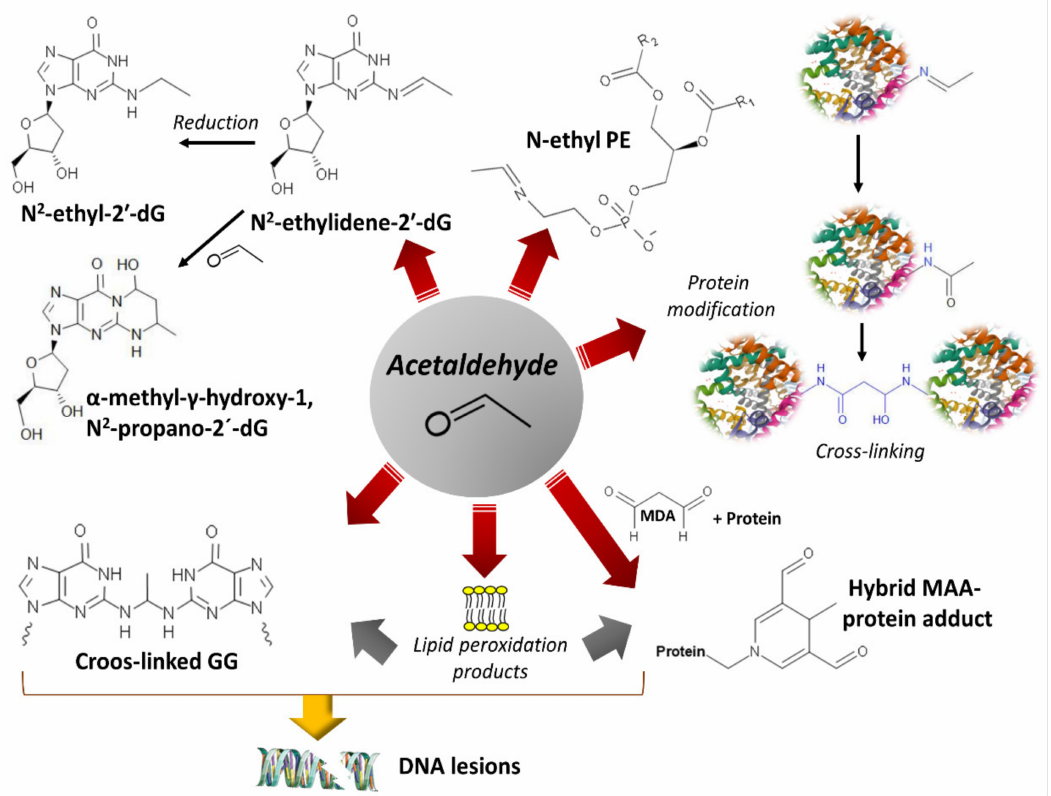
Figure 6. Protein, DNA, and phospholipid adducts are generated by the reaction of electrophilic acetaldehyde with nucle- ophilic groups. Additional secondary transformations may occur. dG, deoxyguanosine; GG, two contiguous deoxyguano- sine on a DNA strand; MDA, malondialdehyde; MAA, malondialdehyde acetaldehyde; PE, phosphatidylethanolamine. The figure includes colored representations of a human nucleosome (Protein Data Bank, code 3AFA). DNA figure: doi.org/10.5281/zenodo.4012404 (accessed on 14 July 2021)